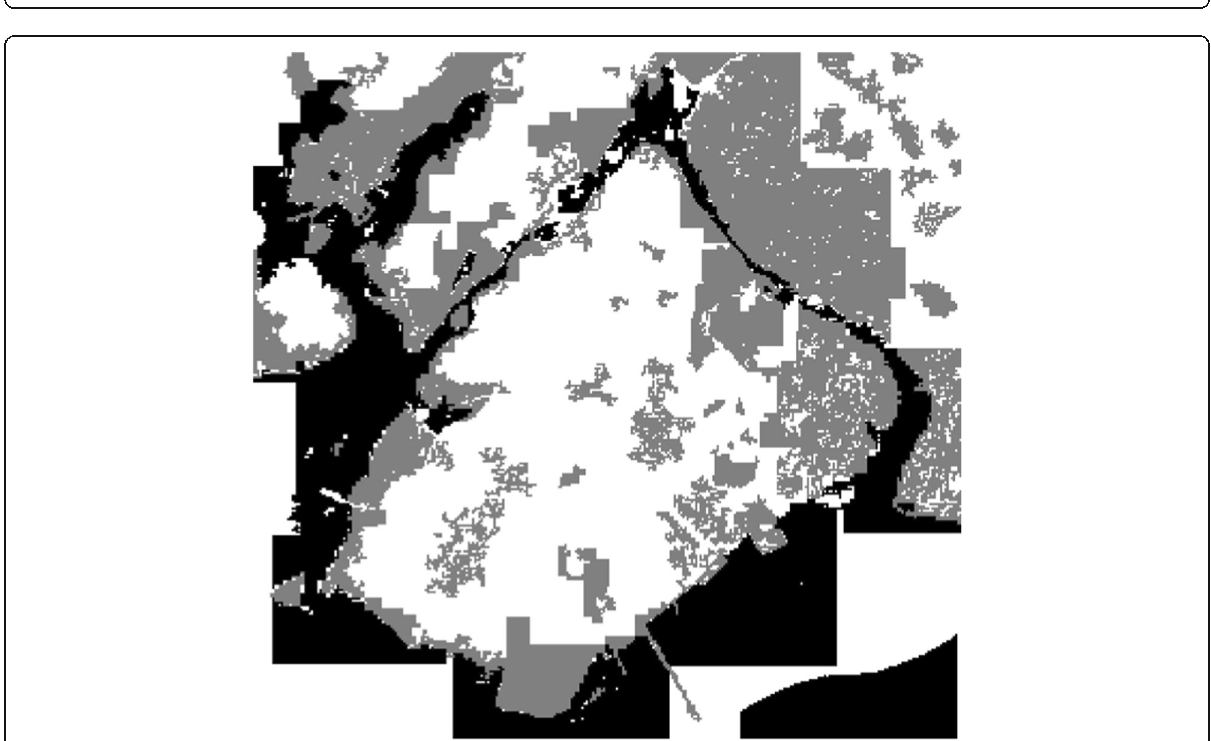
Fig. 6 Reference image for water (black) and non-water bodies (gray), no data